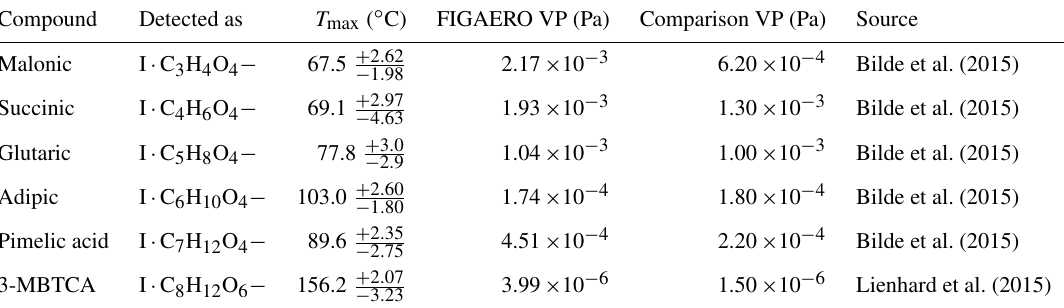
Table 3. Extracted T max values and VP at 298K from chamber SOA experiments as measured by the UMan iodide FIGAERO-CIMS. T max values are an average measured over the seven desorptions (not including background) from the chamber experiment. Errors in the T max are the maximum variation seen within the seven thermograms. Total mass concentrations in the chamber ranged from 0 to 60µg m − 3 throughout the complete